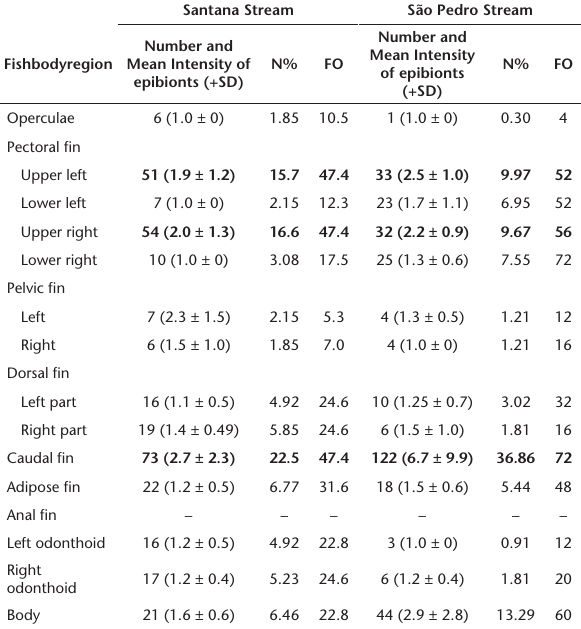
Table 2. Number and mean intensity (+SD) of epibiont, frequency of occurrence in the fish body region of A. multispinis in the Santana and São Pedro streams. (N) Number of fishes, (FO) frequency of occurrence. The highest intensity and occurrence in